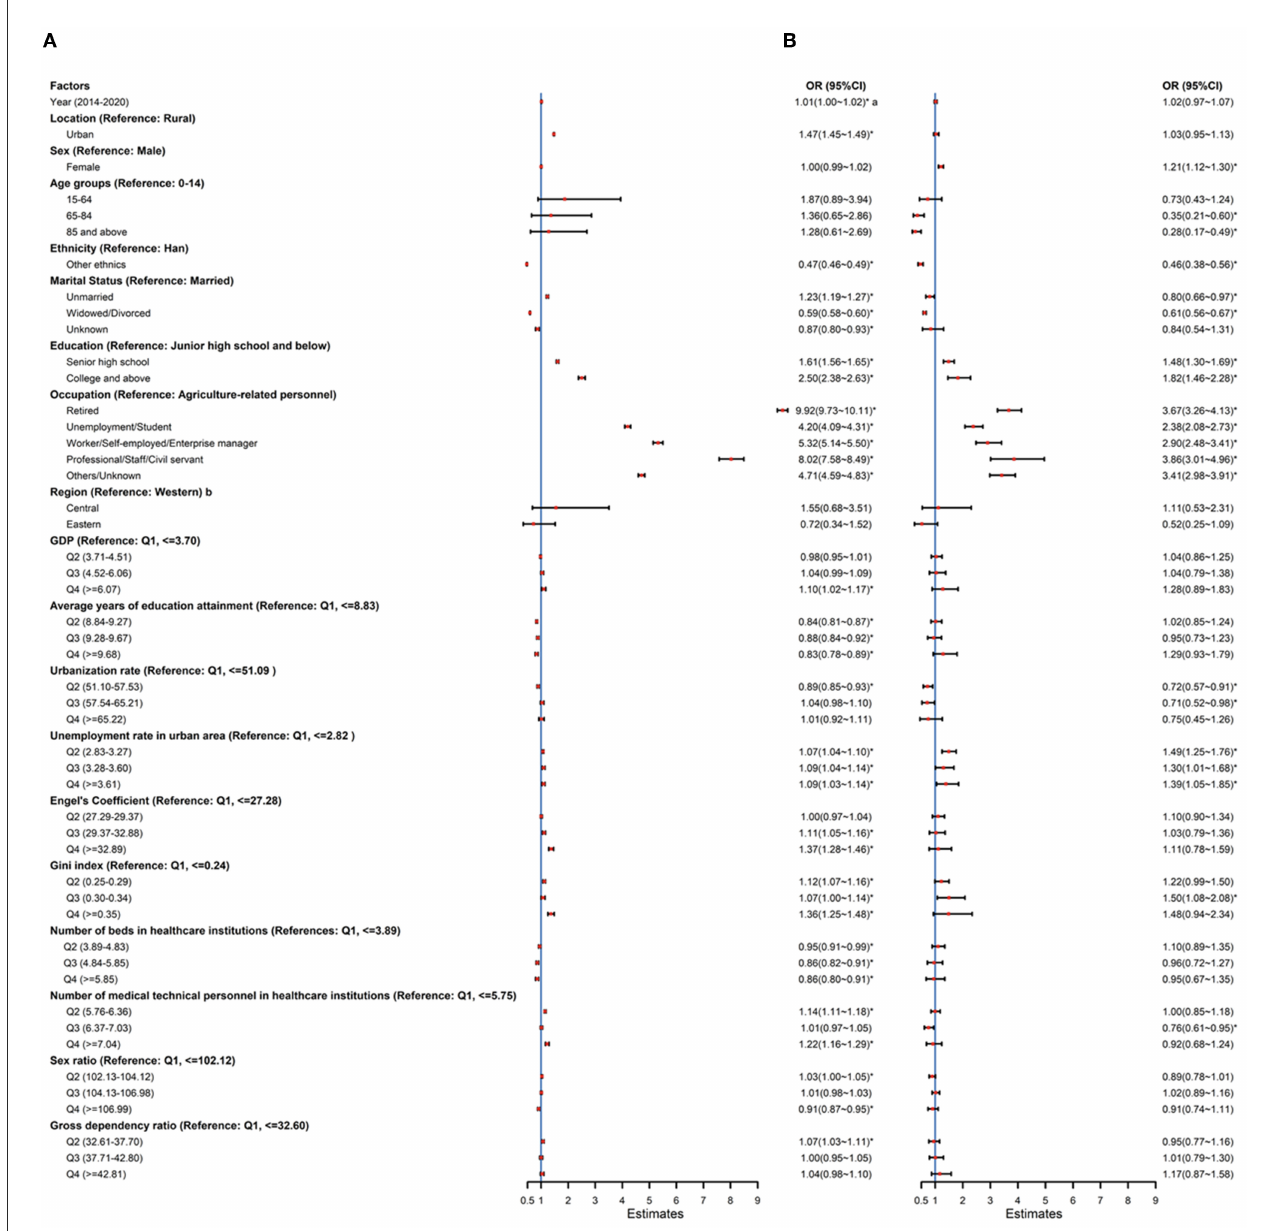
FIGURE4 Associated factors of hospital COPD and asthma deaths in China, 2014–2020: estimated from multilevel logistics regression. OR, odds ratio; CI, confidence interval; Q1, 1st quantile; Q2, 2nd quantile; Q3, 3rd quantile; Q4, 4th quantile. a* P < 0.05. b Region: Western: Inner Mongolia, Guangxi, Chongqing, Sichuan, Guizhou, Yunnan, Tibet, Shaanxi, Gansu, Qinghai, Ningxia, Xinjiang; Central: Shanxi, Jilin, Heilongjiang, Anhui, Jiangxi, Henan, Hubei, and Hunan; Eastern: Beijing, Tianjin, Hebei, Liaoning, Shanghai, Jiangsu, Zhejiang, Fujian, Shandong, Guangdong, and Hainan. (A) COPD and (B)